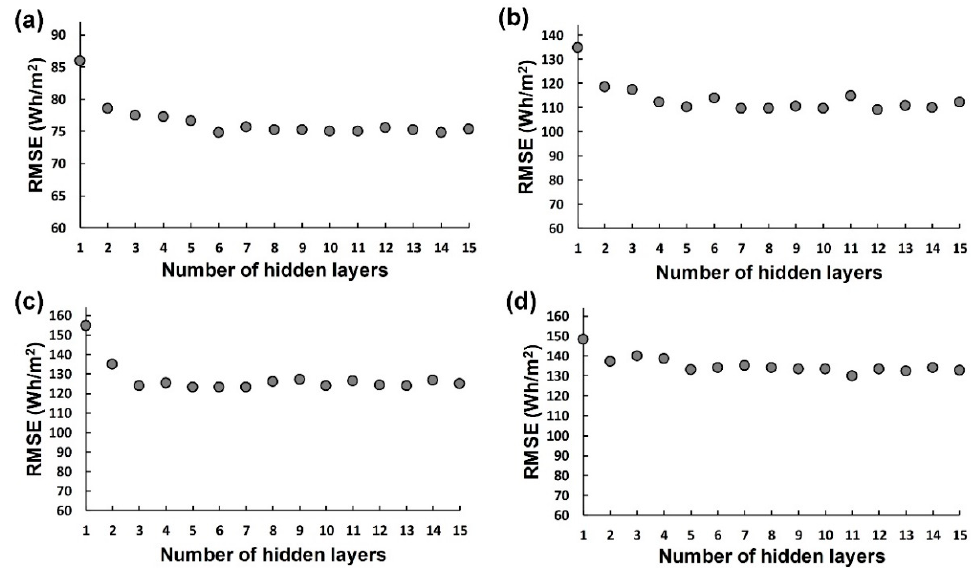
Figure 6. Calibration of hidden layer amount at lead times of ( a ) 1; ( b ) 3; ( c ) 6 and ( d ) 12 h.